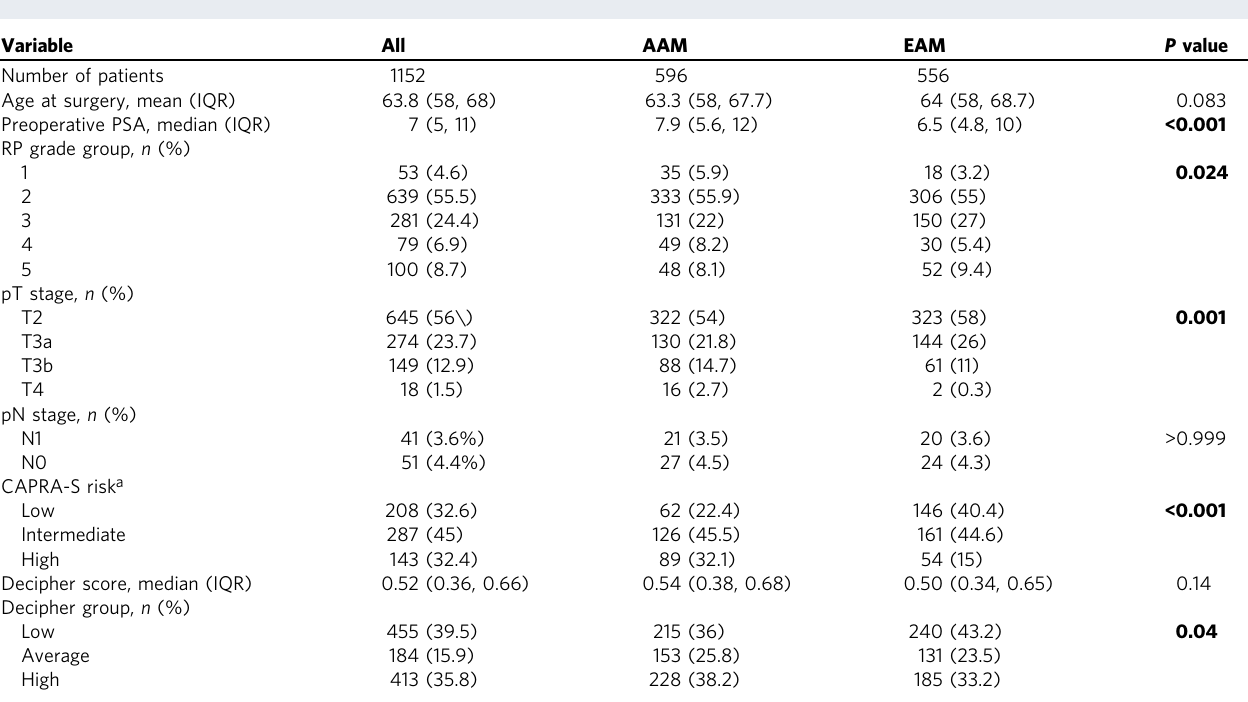
Table 1 Baseline